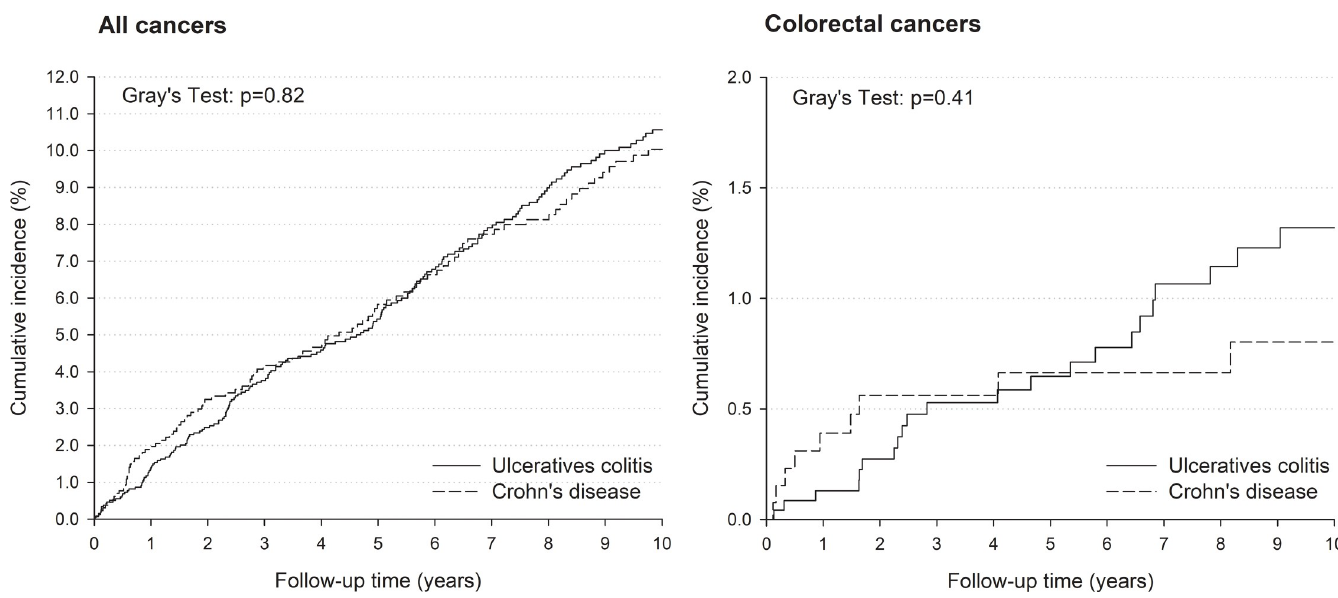
Fig 1. Cumulative incidence of all and colorectal cancers according to IBD type. Friuli Venezia Giulia, northeastern Italy, 1995–2013.